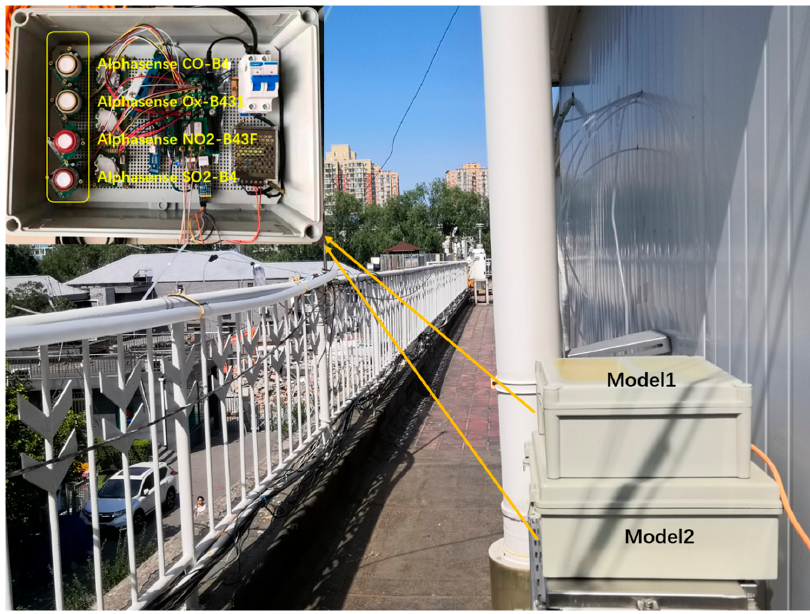
Figure 1. Photographs of multipollutant measuring instruments Model 1 and Model 2.